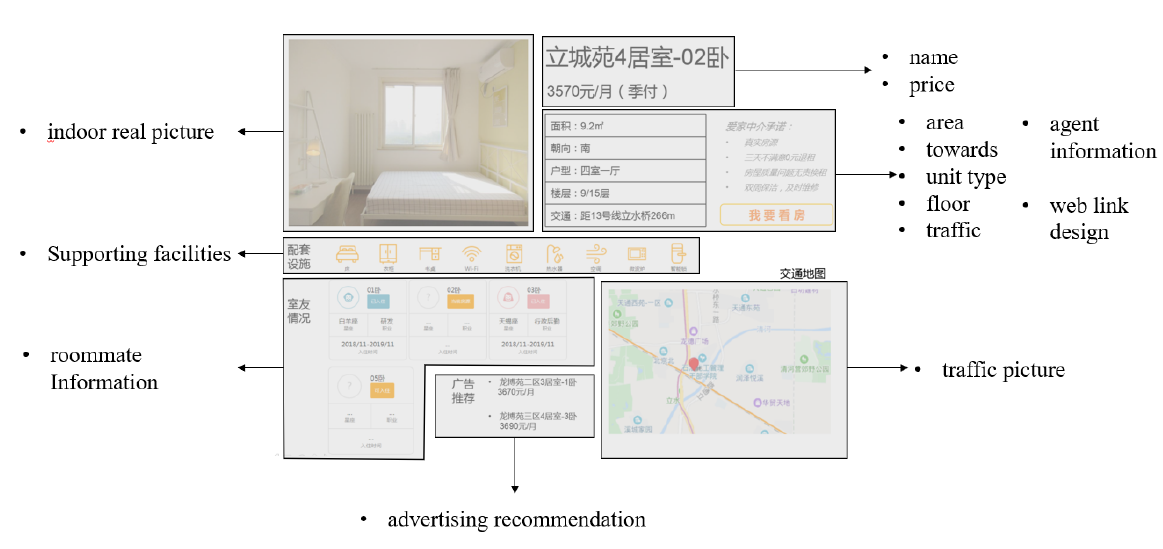
Fig. 2 Example of housing information page prompted by multiple lists in the